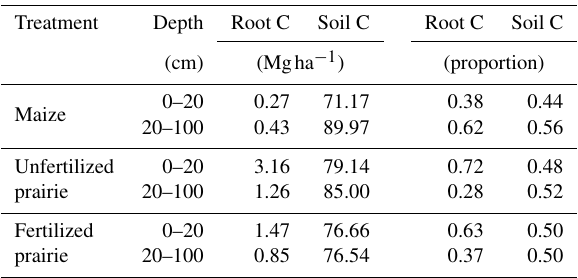
Table 2. Root pool and soil organic C found above and below